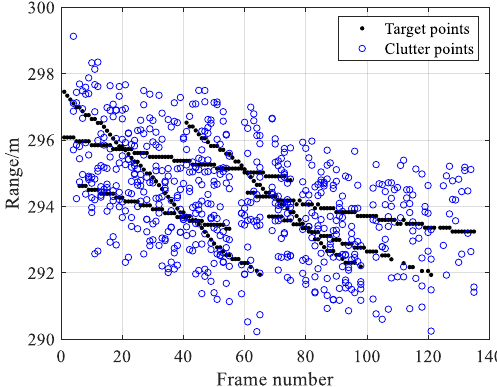
Figure 12. Measurements after CFAR